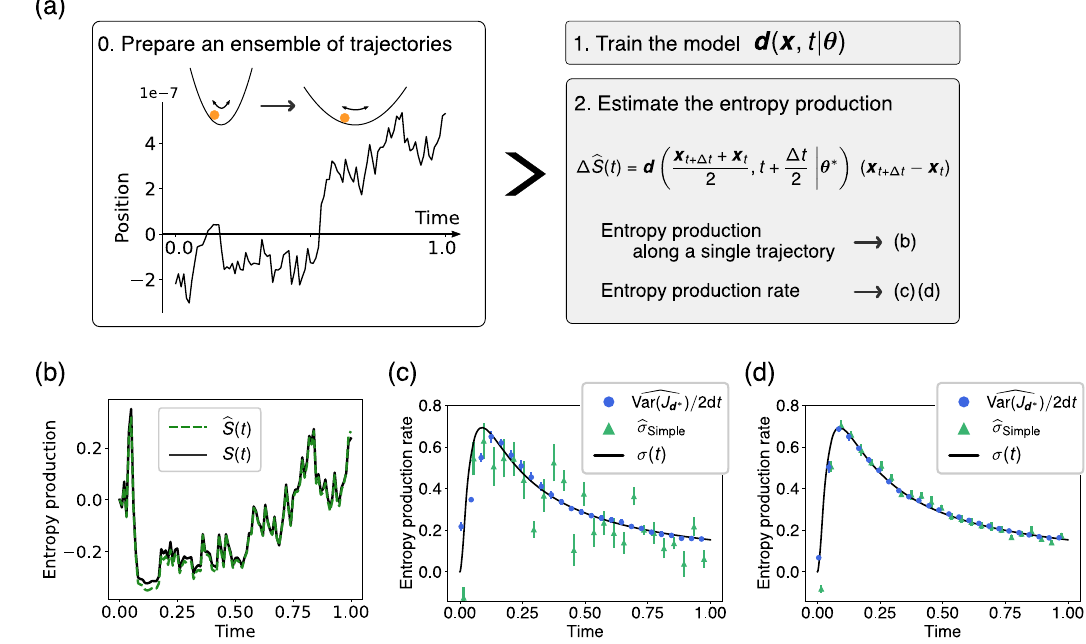
Fig. 1 Estimating the entropy production along non-stationary trajectories. a Schematic of our inference scheme. The box on the left displays a trajectory generated by the breathing parabola model in which a fl uctuating colloidal particle (orange circle) inside a harmonic trap is driven out of equilibrium as the stiffness of the trap decreases. The system parameters for the simulations shown here are: the parameter for the protocol of the changing stiffness α = 11.53, the diffusion constant D = 1.6713 × 10 − 13 , the time interval of trajectories Δ t = 10 − 2 , and the observation time τ = 1. The position at time t is obs described as x t . The box on the right displays the steps in our inference scheme: we train the model function d ( x , t ∣ θ ) with parameters θ to get the optimal values θ * , and use them for estimating the (single-step) entropy production Δ b S . b Estimated entropy production along a single trajectory. The dashed green line is the estimated entropy production, and the solid black line is the true entropy production calculated analytically. The estimation is conducted for the trajectory depicted in panel ( a ) after training the model function using 10 5 trajectories. The blue circles (variance-based estimator (Eq. (14)) and green triangles (simple dual representation (Eq. (10)) are the estimated entropy production rate using ( c ) 10 4 or ( d ) 10 5 trajectories, and the black line is the true value. The model function is trained with the simple dual representation in both cases. As is evident, the variance-based estimator reduces the statistical error signi fi cantly. In ( c ) and ( d ), the mean of ten independent trials are plotted for the estimated values, and the error bars correspond to the standard ffiffiffiffiffi p deviation divided by 10